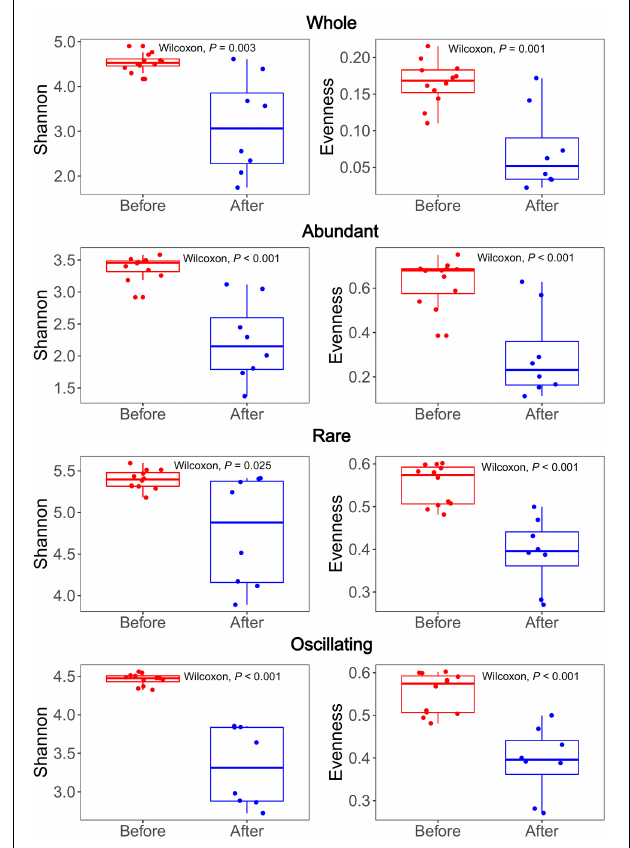
FIGURE 3 | Bacterial alpha diversity comparison between the communities before and after snowfall. Each dot represents an individual sample. For both Shannon and Evenness indices, significant higher diversity was observed in communities before snowfall in the whole, abundant, rare and oscillating communities (Wilcoxon rank-sum test, P < 0.05).